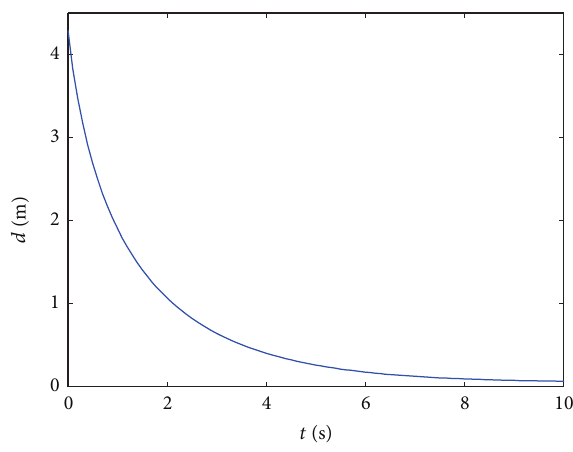
Figure 11: The third step. The distance between the current config- uration and the desired configuration in the third